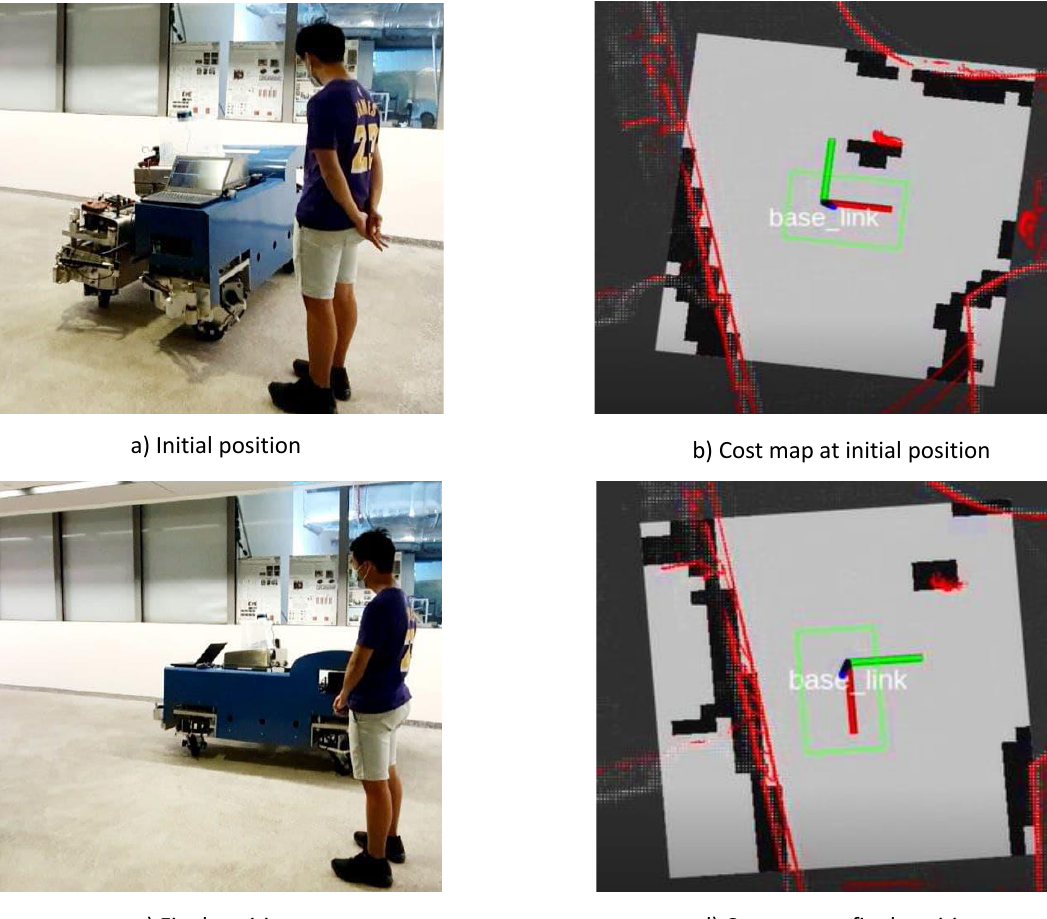
Figure 10. Rotation awhile avoiding pedestrians depicting Scenario S2 (Figure